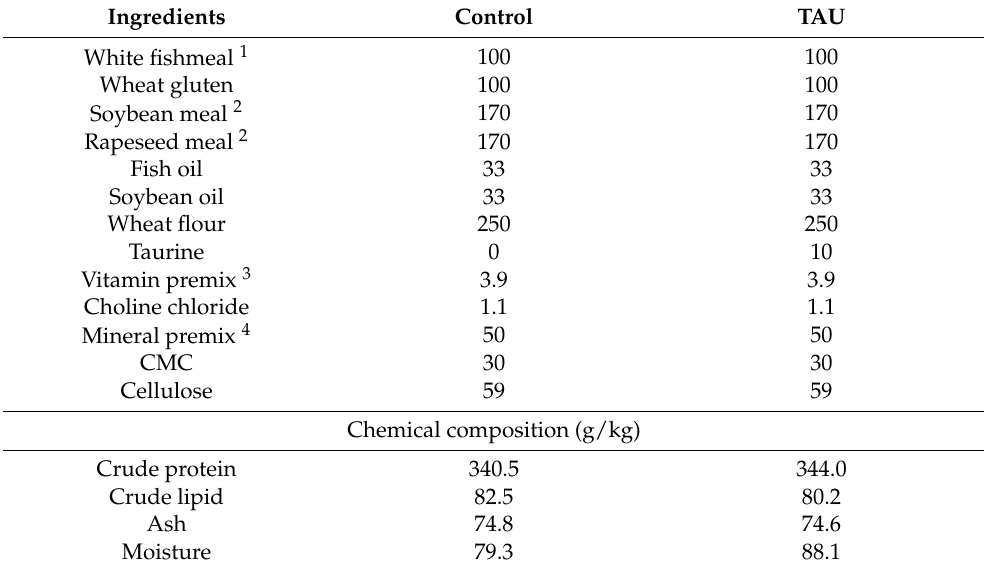
Figure 1. Experimental design. Control: control diet; TAU: diet supplemented with taurine. Table 1. Ingredients and proximate composition of the experimental diets